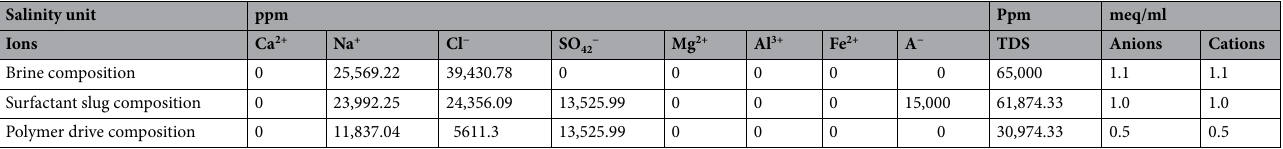
Table 4. Compositions of different waters used in the simulation runs (Tagavifar et al . 18